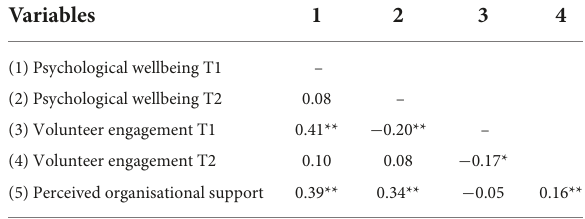
TABLE 5 Pearson’s correlations for